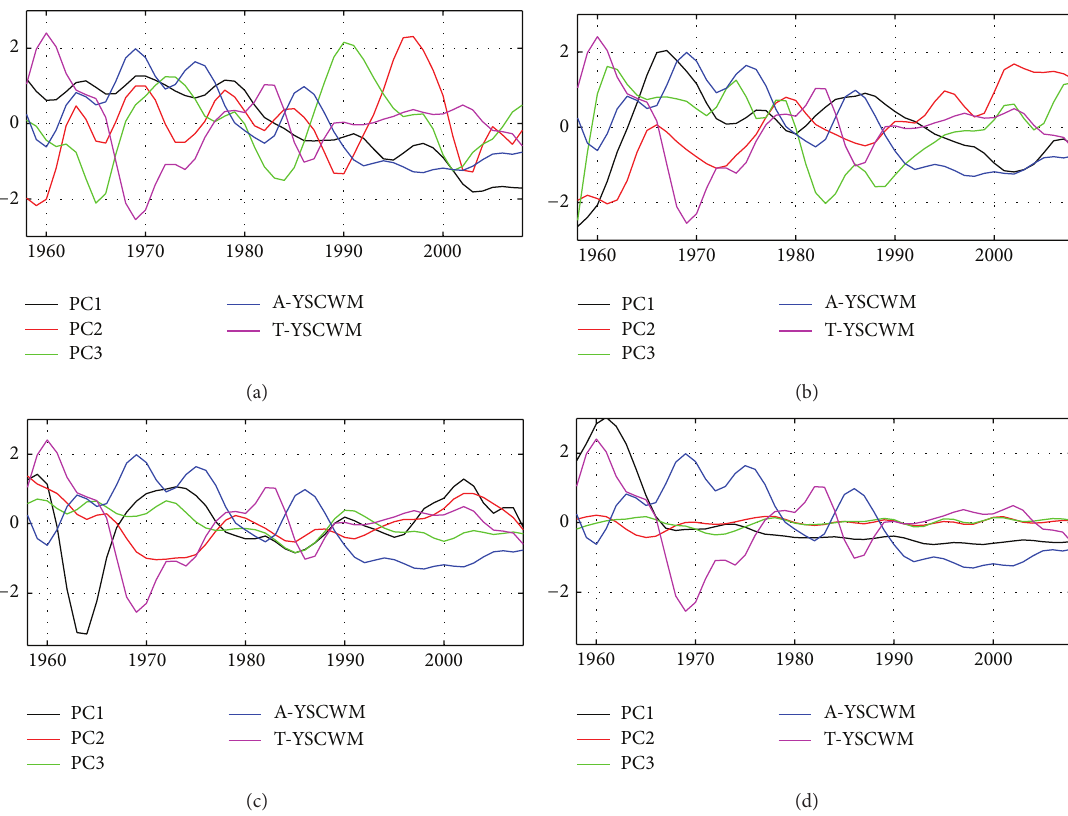
Figure 11: Decadal time series of (a) EOF1, EOF2, and EOF3 of winter heat flux, and the A-YSCWM and T-YSCWM in August (b) EOF1, EOF2, and EOF3 of summer heat flux, and the A-YSCWM and T-YSCWM in August (c) EOF1, EOF2, and EOF3 of winter wind stress, and the A-YSCWM and T-YSCWM in August (d) EOF1, EOF2, and EOF3 of summer wind stress, and the A-YSCWM and T-YSCWM in August. All of the time series are standardized. The A-YSCWM and T-YSCWM represent the area and averaged temperature of the YSCWM,